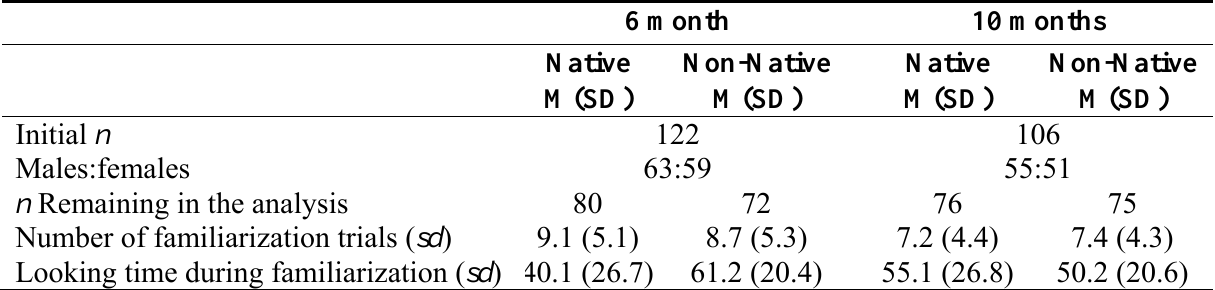
Table 1. Participant characteristics. Initial n reflects participants entered in the study at the time of recruitment. By 10 months some were lost to follow-up. A subset of these infants at each age produced sufficient valid trials to be included in the analysis. For those infants, the number of familiarization trials and looking time during familiarization is